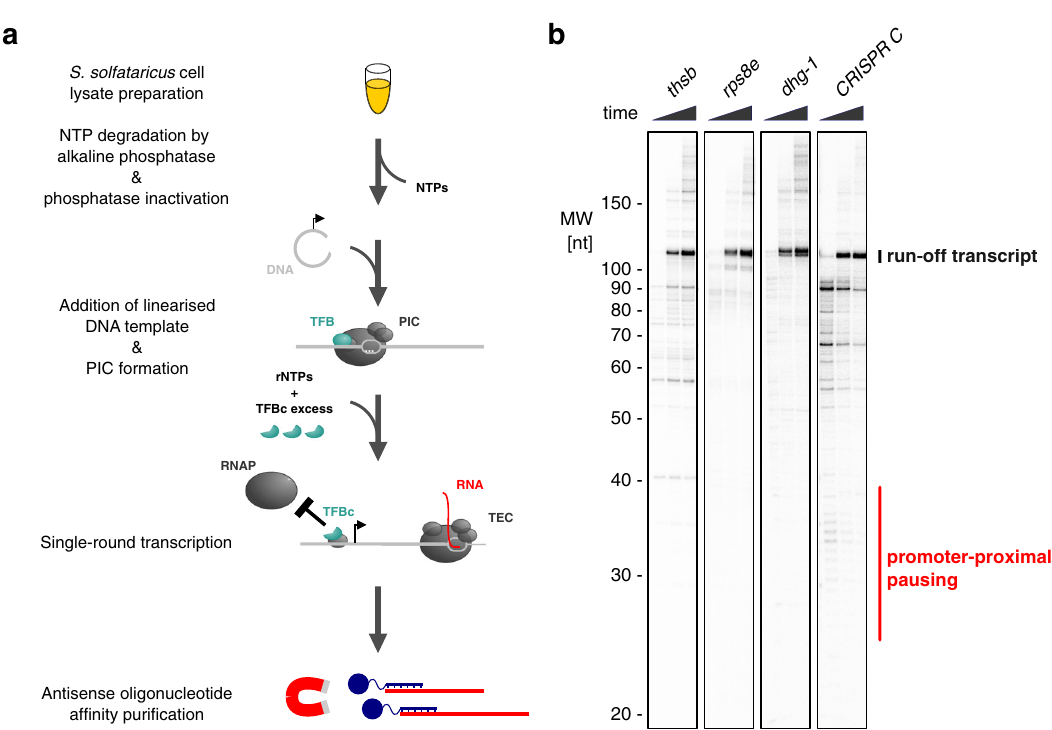
Fig. 4 The CRISPR C promoter shows early pausing in vitro. a Schematic overview of the cell lysate-based synchronised in vitro transcription system for S. solfataricus . Cell lysates were treated with shrimp alkaline phosphatase for NTP degradation before heat inactivation of the phosphatase. Linearised plasmid DNA containing a S. solfataricus promoter were added to allow PIC formation on the templates with inherent initiation factor TFB. Simultaneously with the addition of ribonucleotides to allow the PICs to initiate a single round of transcription, we added an excess of a recombinant TFB variant termed TFBc that blocks subsequent rounds of PIC formation. The generated transcripts were puri fi ed by af fi nity puri fi cation using immobilised 25 nt antisense oligonucleotides. b Synchronised in vitro transcription assay with two promoters showing high TEC escape ( thsB and rps8e ) and two promoters showing low TEC escape in vivo ( dhg-1 and CRISPR C ). Samples were withdrawn 15 s, 30 s and 45 s after simultaneous addition of 50 µ M rNTPs including [ α - 32 P]- UTP and TFBc. Puri fi ed radiolabelled transcripts were resolved on a denaturing polyacrylamide gel. The position of run-off transcripts and transcripts resulting from pausing in the promoter-proximal region is indicated. A representative experiment of three technical replicates is